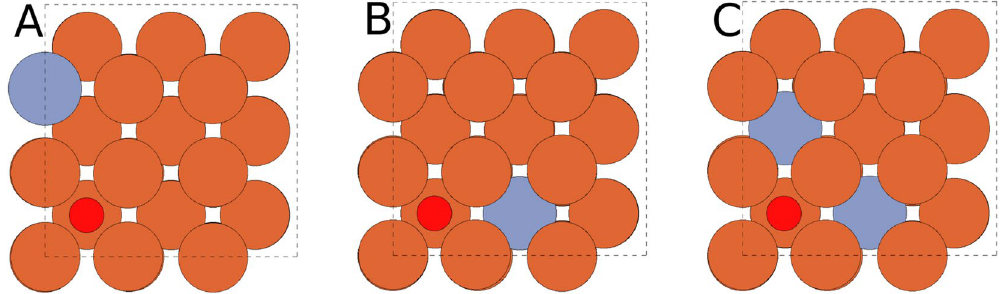
Figure 4. Illustrations of the three hollow-site configurations in which oxygen is more weakly bound than at the hollow site of a pure Fe surface. The positions of Cr atoms (indicated with blue-gray color) are ( A ) site 3, ( B ) site 9 and ( C ) sites 8 and 9. The oxygen position is indicated by the small red